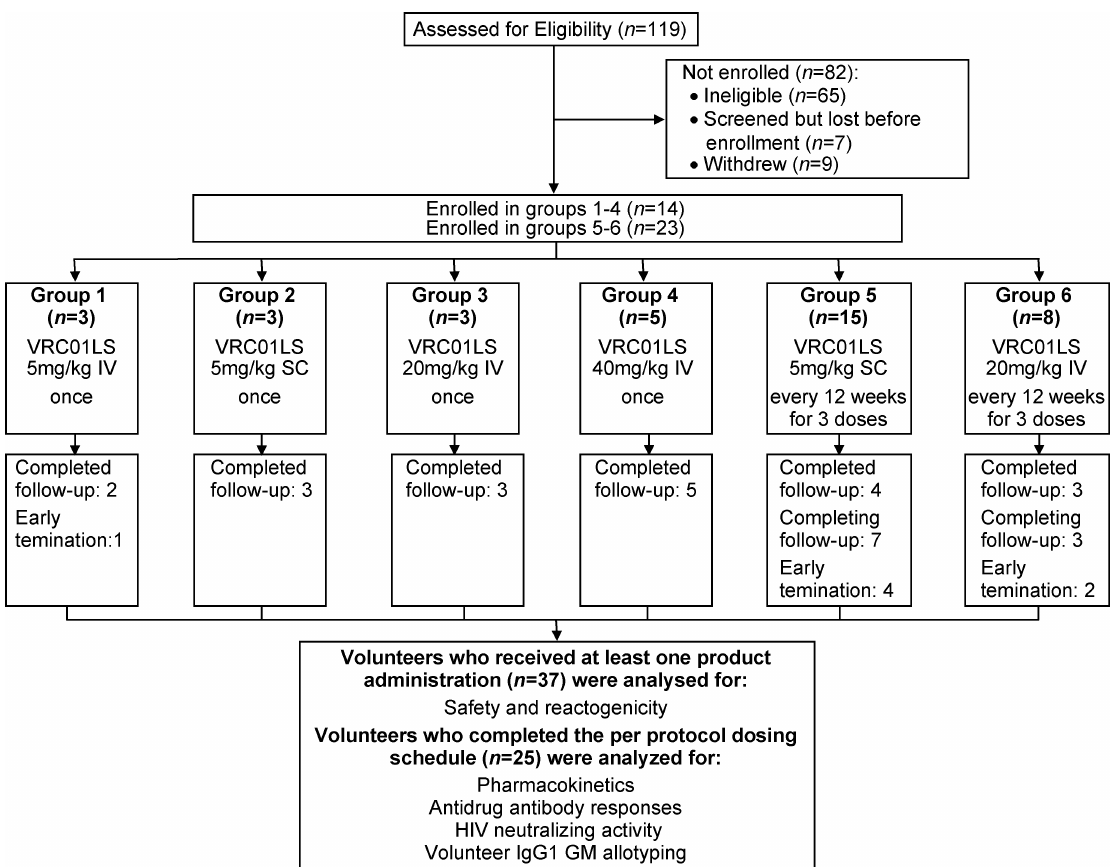
Fig 1. CONSORT flow diagram of the VRC 606 trial. Thirty-seven volunteerswere allocatedto 6 groups. All volunteerswho received at least one VRC01LSadministration were analyzedfor safety and reactogenicity. All volunteerswho completedthe per-protocol dosing scheduleby the time of manuscript submission( n = 25) were additionallyanalyzedfor pharmacokinetic parameters, serum neutralization activity, anti-drugantibodies, and IgG1 GM allotype.These 25 volunteerswere all the volunteersin groups1–4, the first six volunteers in group 5, and the first five volunteers in group 6. GM, geneticmarker; IgG1, immunoglobulin G subclass 1; IV, intravenous; SC, subcutaneous; VRC,